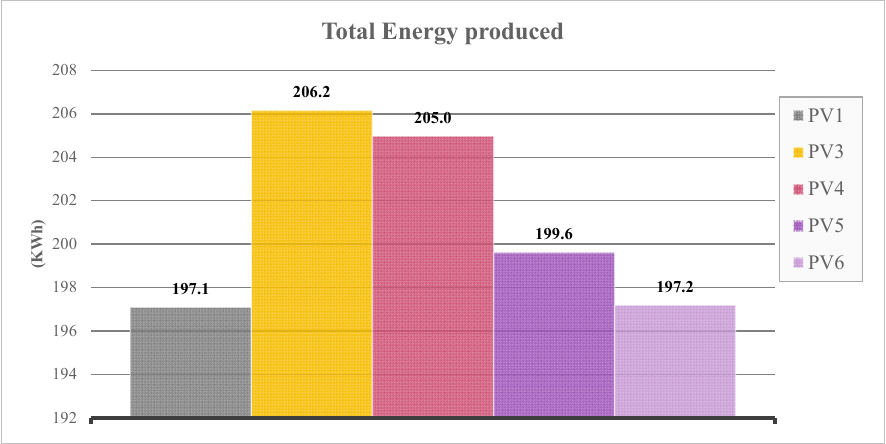
Figure 8. Total energy produced by the reference module and the four PV modules in the entire period of analysis.